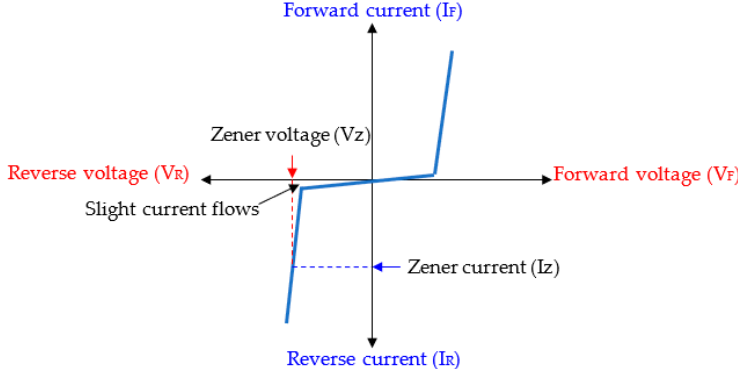
Figure 18. Example of Vz–Iz characteristics of Zener diode.